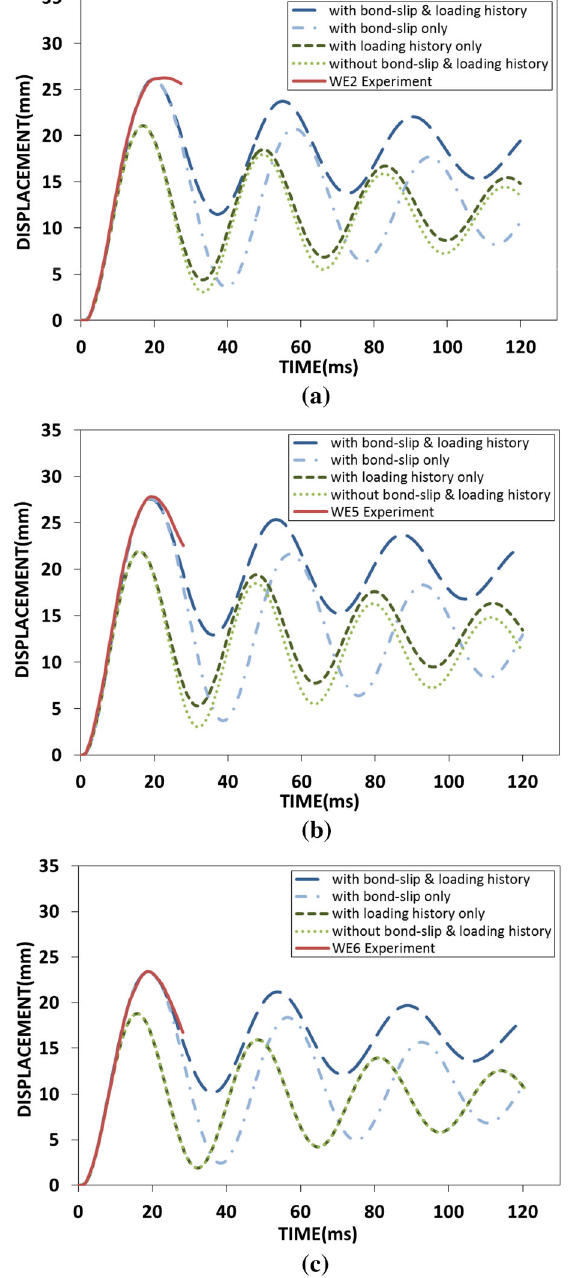
Fig. 10 Mid-span deflection with time for WE beams. a WE2, b WE5, and c WE6.